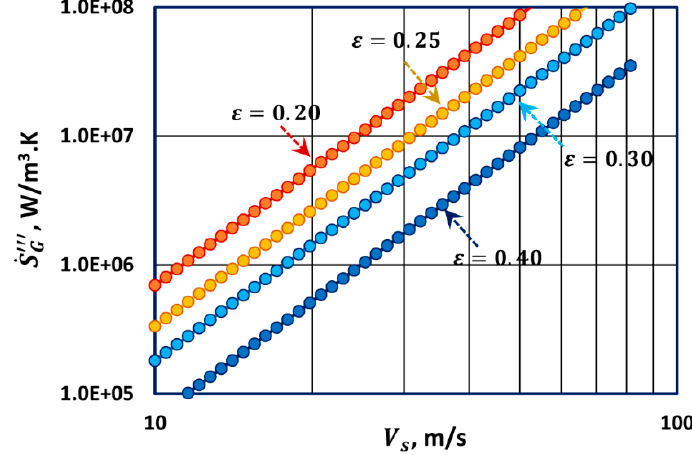
Figure 14. Effect of bed porosity on the rate of entropy generation per unit volume of the packed bed in turbulent flow ( T = 298.15 K, d p = 1 mm, µ = 18.5 µ Pa · s, ρ = 1.184 kg / m 3 ). The data points are generated using Equation (52).